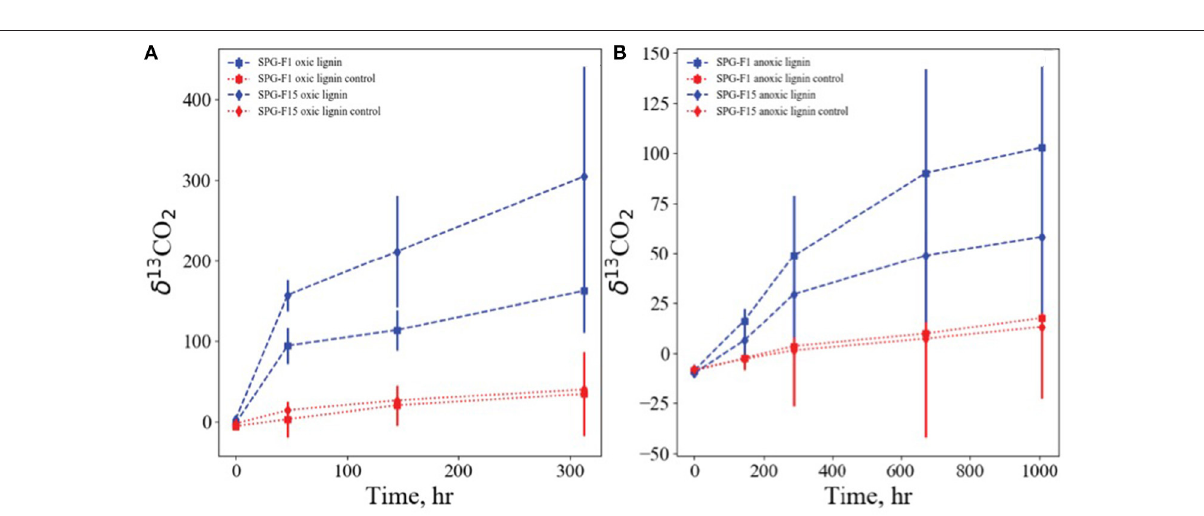
the energetic limits of life (D’Hondt et al., 2013).